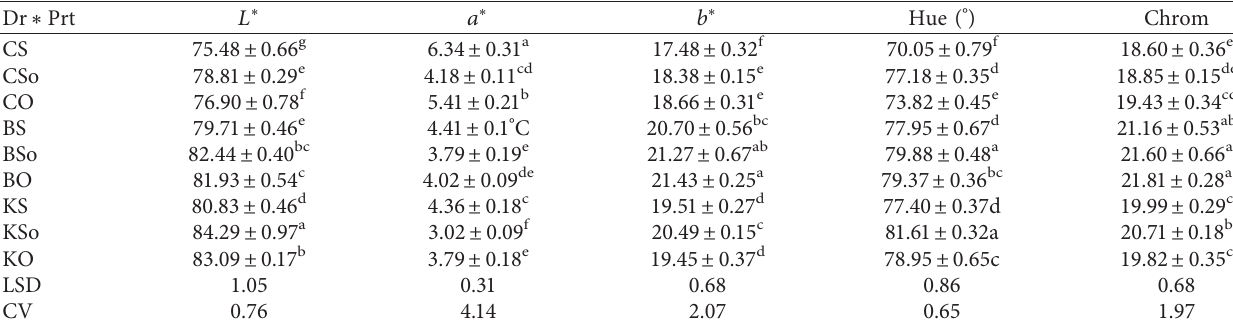
Values are mean ± standard deviation. Values in the same column followed by different letters are significantly different ( P < 0 . 05). CS: control and sun-dried sample, CSo: control and solar-dried sample, CO: control and oven-dried sample, BS: blanching and sun-dried sample, BSo: blanching and solar-dried sample, BO: blanching and oven-dried sample, KS: potassium metabisulphite and sun-dried sample, KSo: potassium metabisulphite and solar-dried sample, KO: potassium metabisulphite and oven-dried sample, LSD: least significant difference, and CV: coefficient of